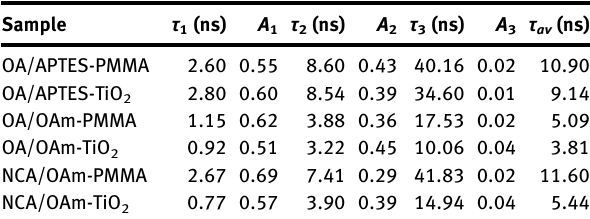
Figure 2: (A – C) PL decays of OA/ APTES-CsPbBr 3 , OA/OAm-CsPbBr 3 and NCA/OAm-CsPbBr 3 PeNCs attached to PMMA (green) and TiO 2 (orange) fi lms. In- sets: schematic diagram presenting the capping ligand on CsPbBr 3 PeNCs, (D) comparison of decay curves of all three CsPbBr 3 PeNCs-ligand systems coated on PMMA.